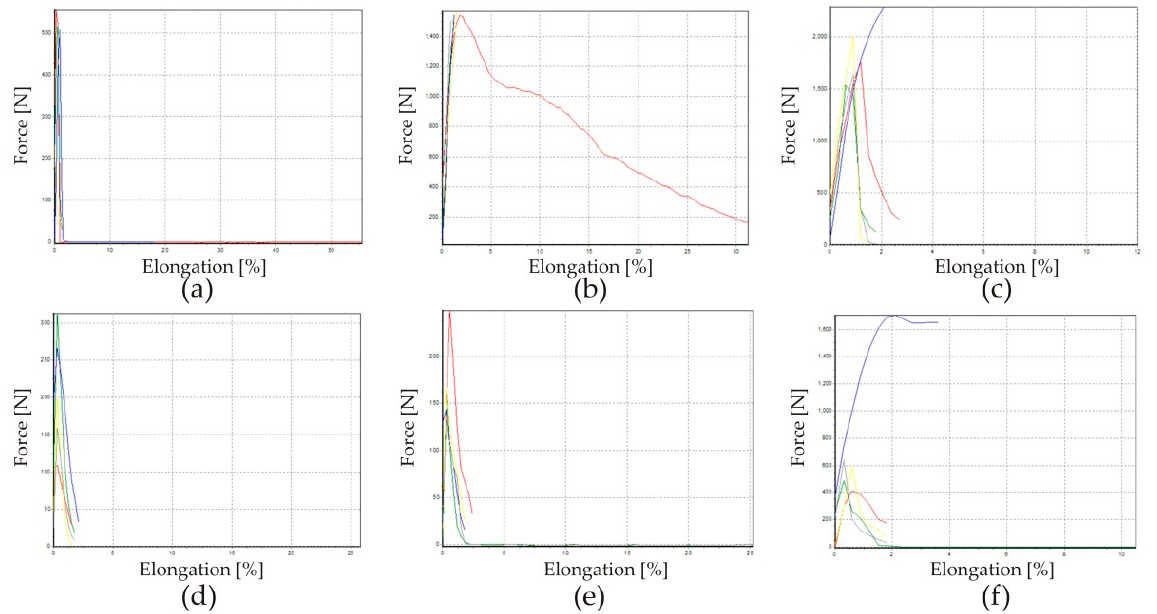
Figure 4. Test results of the elongation of PLA/cotton/PLA with fillings 20% ( a ), 60% ( b ) and 100% ( c ); and PLA/polyester/PLA with fillings 20% ( d ), 60% ( e ) and 100% ( f ).